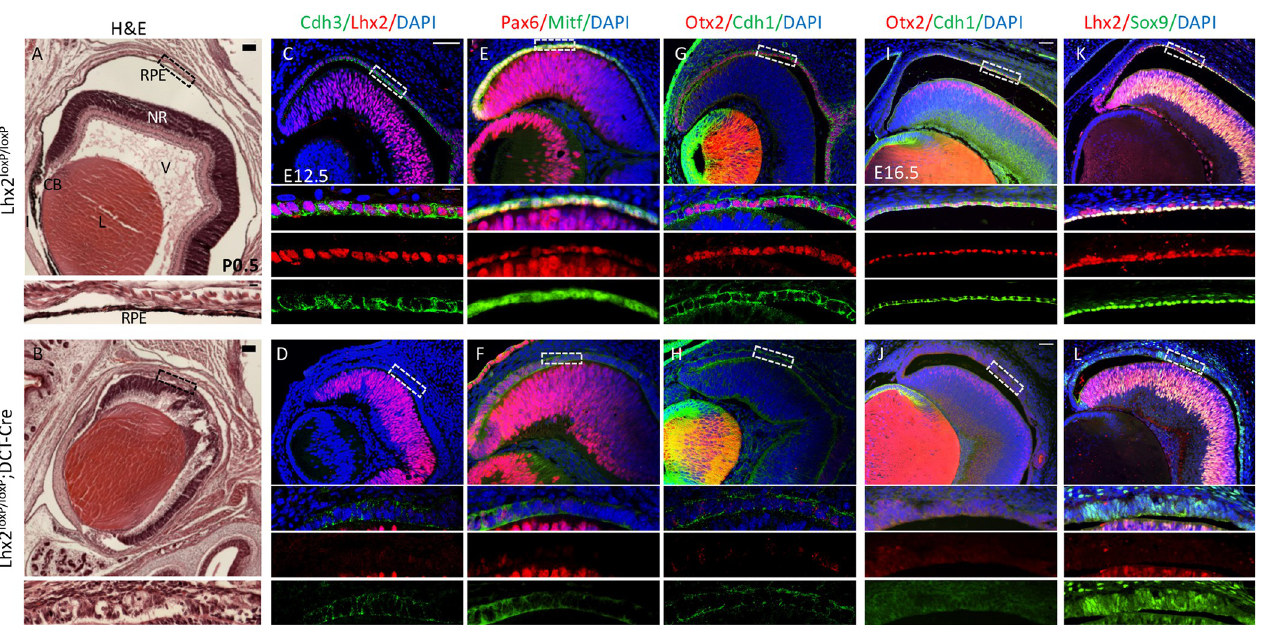
Fig 1. Lhx2 is required for maintaining RPE fate in mice. Lhx2 loxP/loxP control (A, C, E, G, I, K) and Lhx2 loxP/loxP ;Dct-Cre conditional mutation in RPE (B, D, F, H, J, L) analyzed by hematoxylin and eosin (HE) at P0 (A, B) and at E12.5 by antibody labeling for detection of (C, D) Cdh3 (green) and Lhx2 (red); (E, F) Mitf (green), Pax6 (red); (G, H) Cdh1 (green), Otx2 (red), and at E16.5 by antibody labeling for detection of (I, J) Cdh1 (green), Otx2 (red); (K, L) Sox9 (green), Lhx2 (red). Counterstaining with DAPI (blue). The insets below are higher magnifications of the RPE presenting the merged and separate channels. Scale bar in A, B is 100 μ m insets are 10 μ m. Scale bar C–L is 50 μ m, lower insets are 10 μ m. CB, ciliary body; HE, hematoxylin and eosin; L, lens; NR, neuroretina; RPE, retinal pigmented epithelium; V, vitreous.